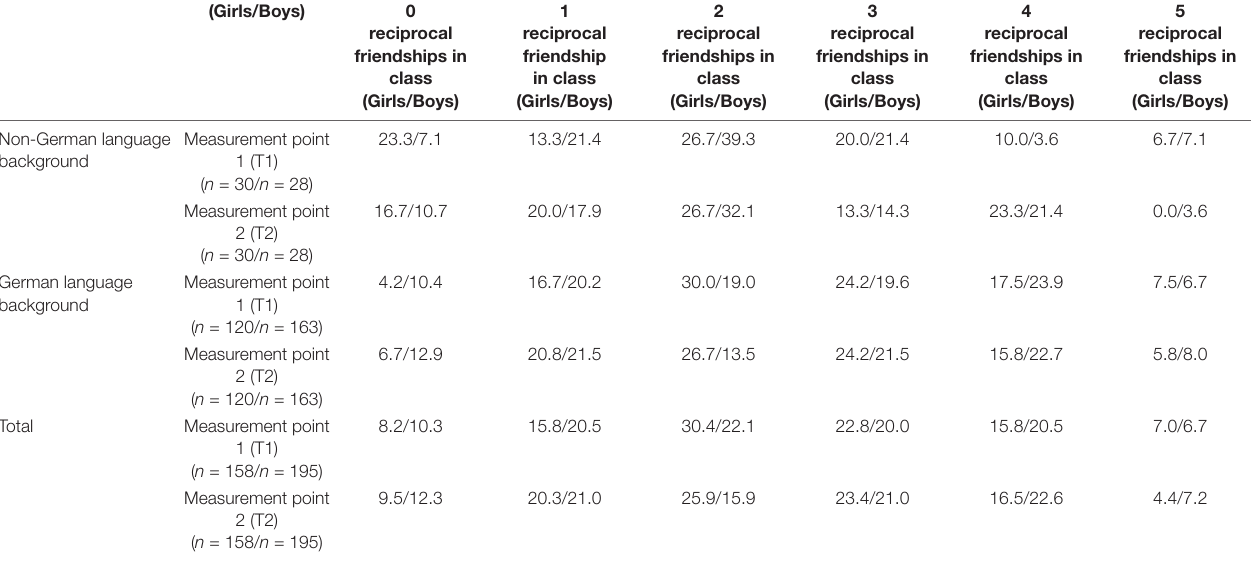
TABLE 2 | Distribution of percentage of friendships by gender and migration background at the first (T1) and second (T2) measurement point. (Girls/Boys)